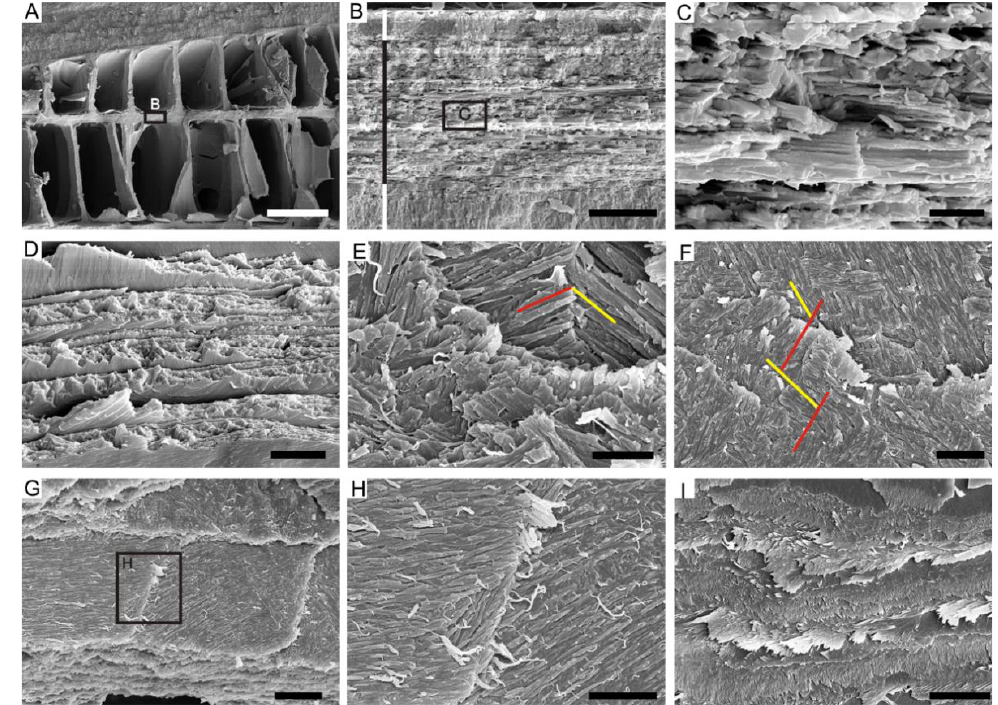
Figure 3. The LF nacre of extant coleoid Sepia esculenta . ( A ) Specimen OUCCMG Mo00002, transverse section showing the dorsal shield and ventral chambered zone. ( B ) Specimen OUCCMG Mo00003, close-up examination of the septum showing three superimposed structural layers; prismatic form marked by white bars, LF nacre layer marked by black bar. ( C ) Amplification of ( B ) showing the stacked lamellae of the LF nacre. ( D ) Specimen OUCCMG Mo00004, fractural surface showing